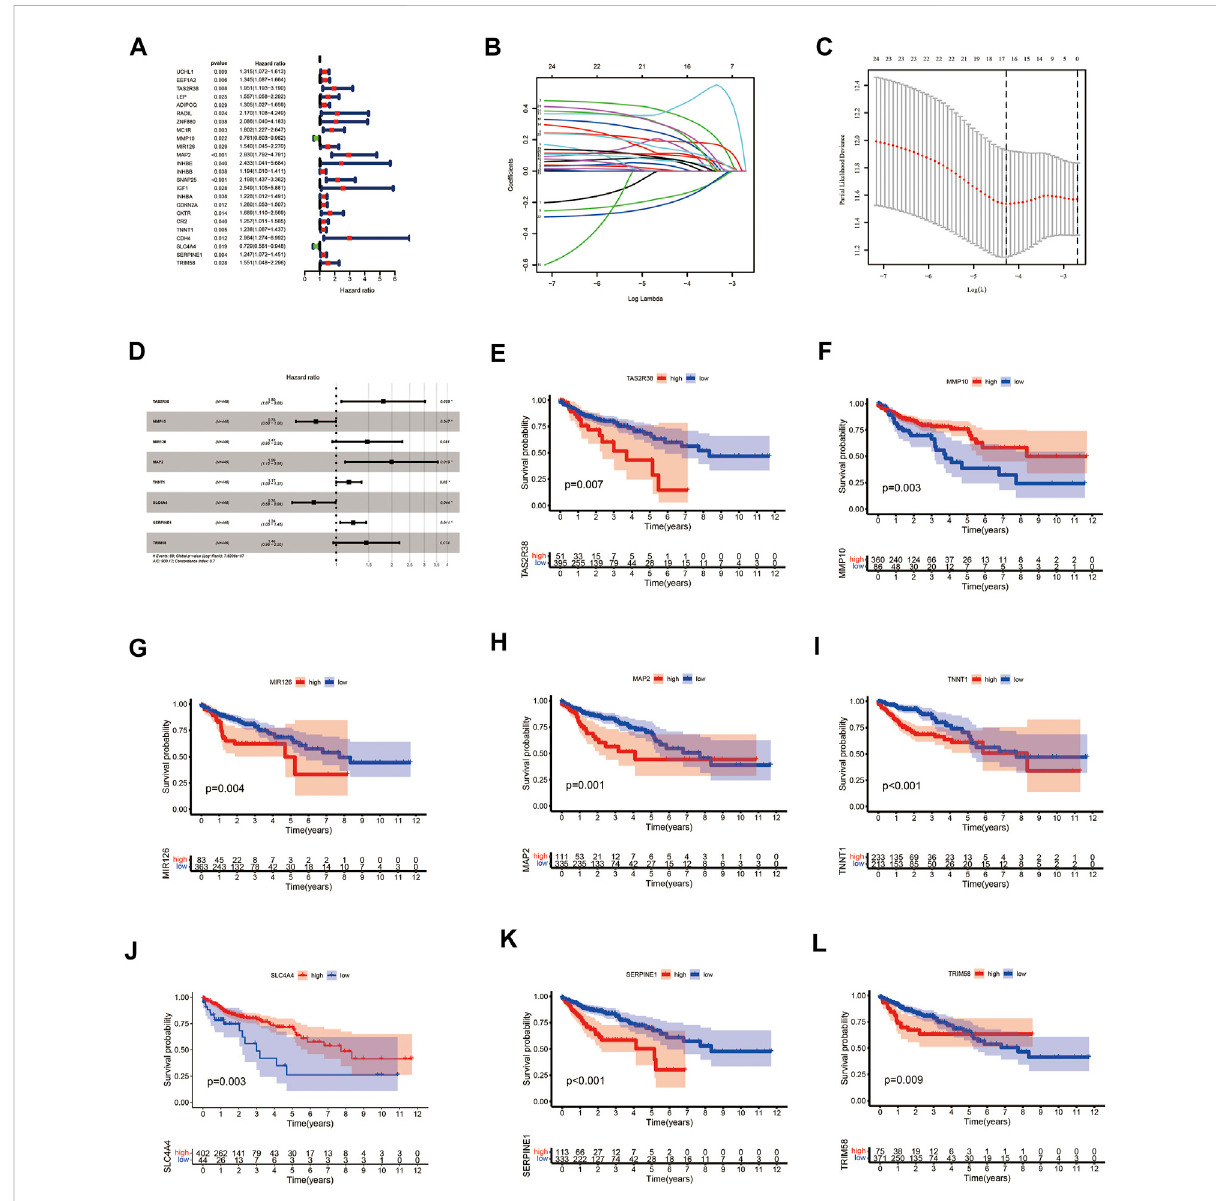
FIGURE 4 Prognostic model of COAD patients constructed by using CCRG. (A) Forest plots of univariate Cox survival analysis of CCRG. (B, C) Coef fi cient pro fi les and cross-validation error rate plots for LASSO regression analysis of CCRG obtained from outcomes of univariate Cox survival analysis, respectively. (D) Forest plots of multivariate Cox survival analysis of genes obtained from outcomes of LASSO regression analysis. (E – L) KM survival curves ofgenesobtained from outcomes ofmultivariateCoxanalysis.COAD: colonadenocarcinoma; CCRG:COAD/COVID-19related genes; KM: Kaplan –